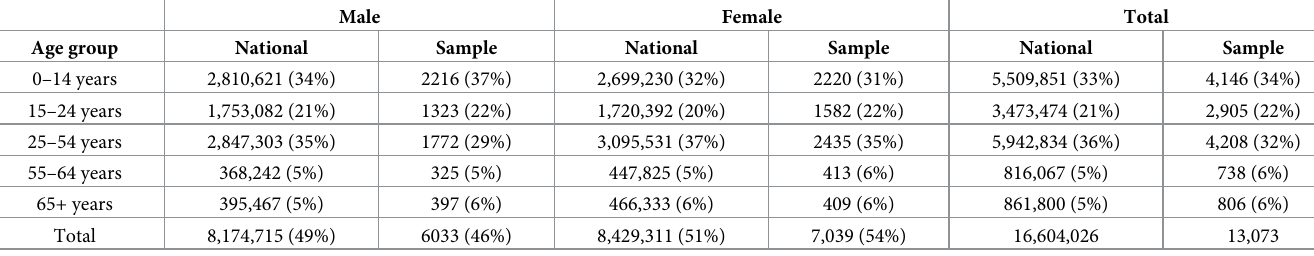
Table 2. Age and sex distribution of the national population and study